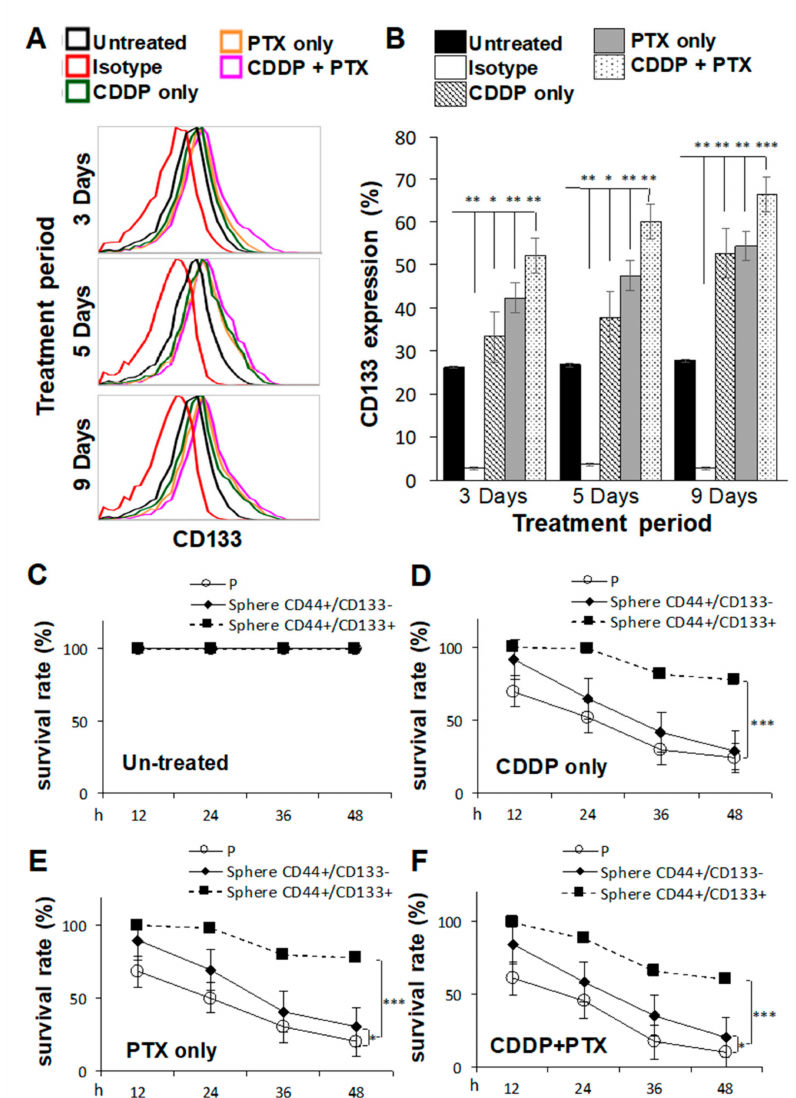
Figure 2. Pretreatment with cisplatin (CDDP) combined with paclitaxel (PTX) synergistically enhanced the sphere-forming ability, cluster of di ff erentiation 133 (CD133) expression, and chemoresistant capacities of cancer stem cell (CSC)-like SKOV3 spheres. SKOV3 parental cells (SKOV3-P) were pretreated with 1 µ M CDDP alone, 1 nM PTX alone, or their combination for 3, 5, and 9 days, and then cells were collected for 4-day sphere-forming and cell surface CD133 expression assays in ( A , B ). CD44 + CD133 − sphere as well as CD44 + CD133 + sphere populations were sorted for cell viability assay comparisons among Untreated ( C ), CDDP-treated ( D ), PTX-treated ( E ), and CDDP / PTX-treated ( F ) after 12, 24, 36, and 48 h of drug treatment. Presented data were acquired from three independent experiments. * p < 0.05, ** p < 0.01, *** p <